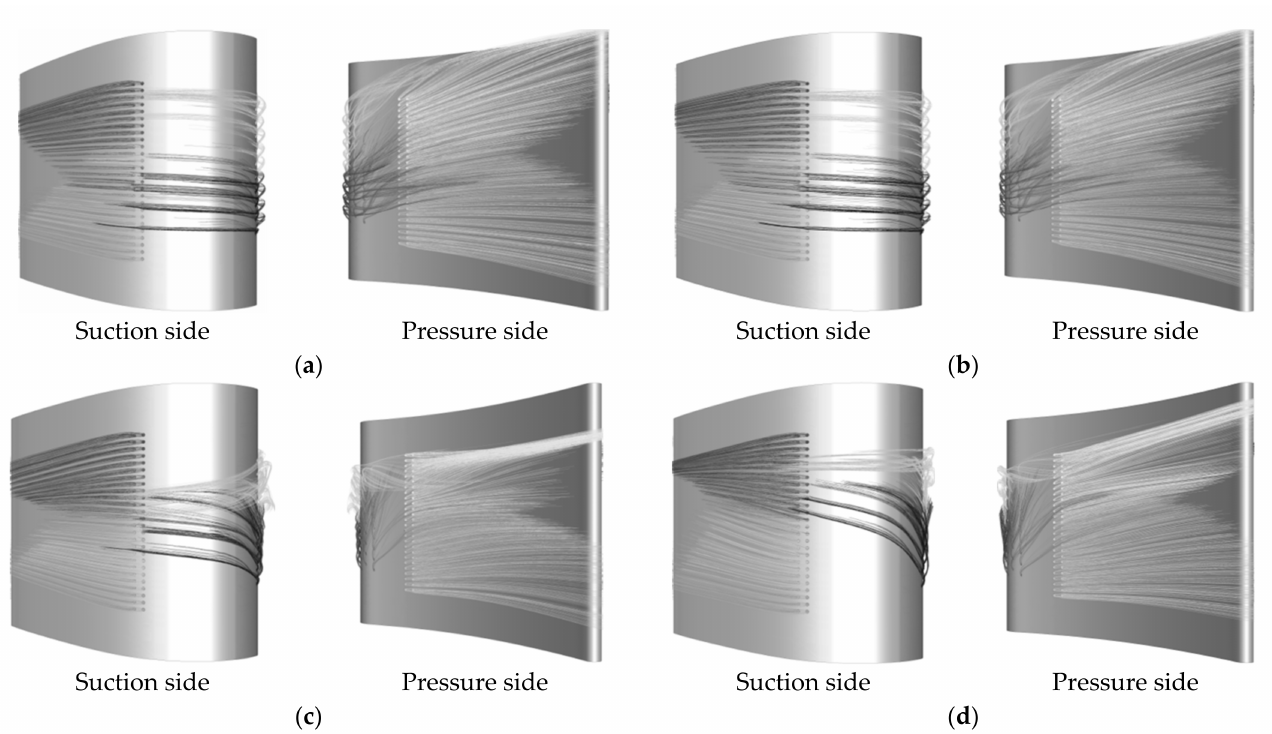
Figure 11. Streamline pattern of coolant for different cases. ( a ) Case 1: uniform inlet; ( b ) Case 2: HS only; ( c ) Case 3: HS and positive swirl; ( d ) Case 4: HS and negative